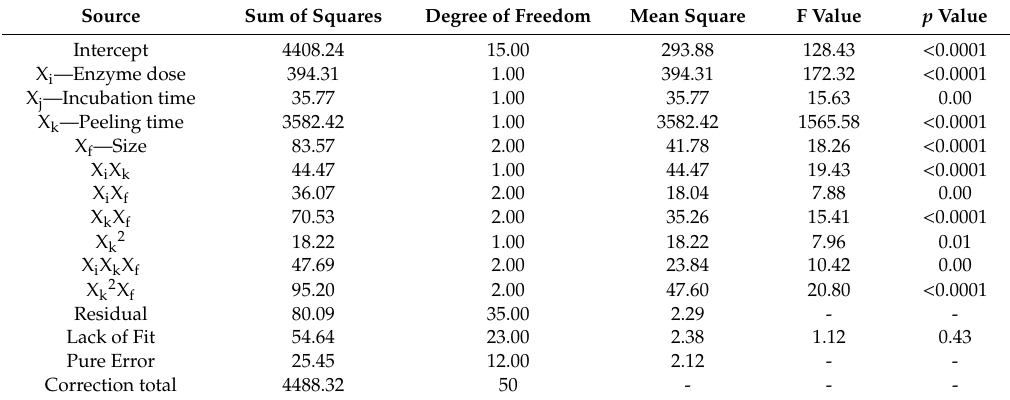
Table 4. ANOVA for reduced polynomial equation for the e ff ect of enzymatic treatment, peeling time and size of tubers on the PSA of cassava tubers.